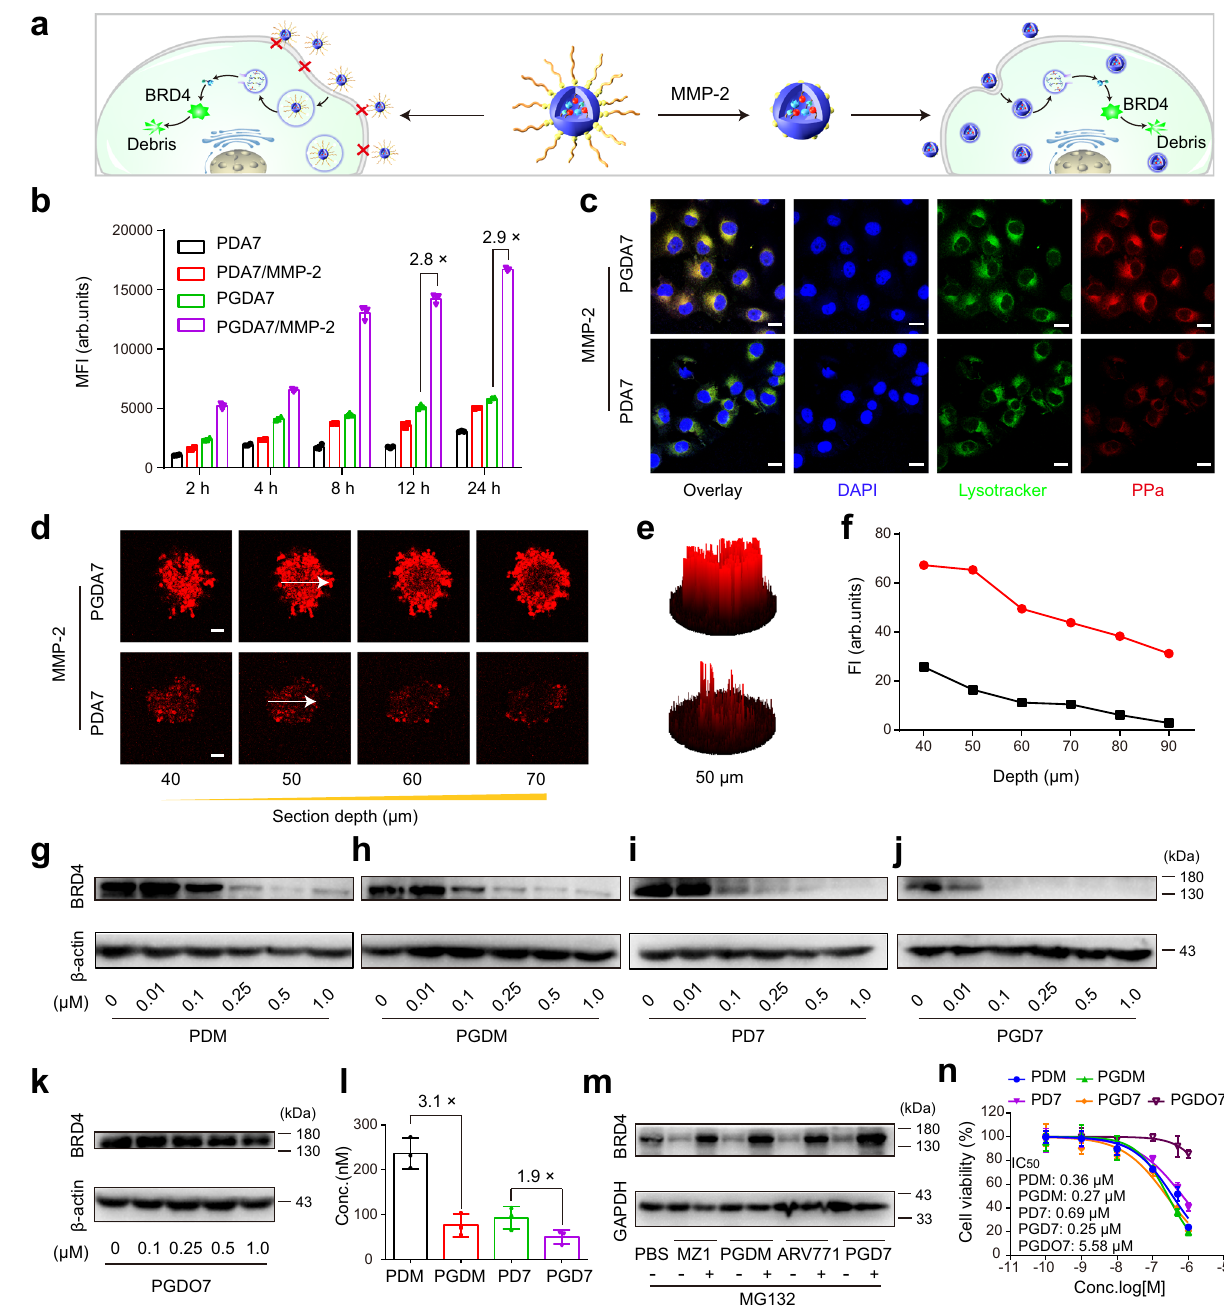
Fig. 3 | Stimuli-activatable POLY-PROTAC NPs displayed increased cellular uptake, tumour penetration and BRD4 degradation performance in vitro. a Cartoon illustration of the MMP-2-triggered cleavage of the PEG corona and promoted cellular uptake of the PGD7 NPs in vitro. b Flow cytometric analysis of PGDA7andPDA7NPscellularuptakeinvitro(theNPswerepretreatedwith0.2mg/ mLMMP-2for1h)( n =3biologicallyindependentcells). c CLSMexaminationofthe intracellular distribution of the POLY-PROTAC NPs after 12h of incubation (scale bar = 20 μ m). d – f MMP-2-responsive PGDA7 NPs displayed increased penetration into MDA-MB-231 MCSs in vitro compared with their MMP-2-nonresponsive PDA7 counterpart. d CLSMexaminationofPGDA7andPDA7NPsdistributionafter12hof incubationinvitro. e 2.5-D reconstructionofthe CLSMimagesata scanning depth of 50 μ m. f Fluorescence intensity of the central region versus Z-axis depth. g – j Reduction-activatable POLY-PROTAC NPs ef fi ciently degraded the BRD4 pro- teinin MDA-MB-231 cells invitro.Westernblot assayof BRD4 degradation inMDA-